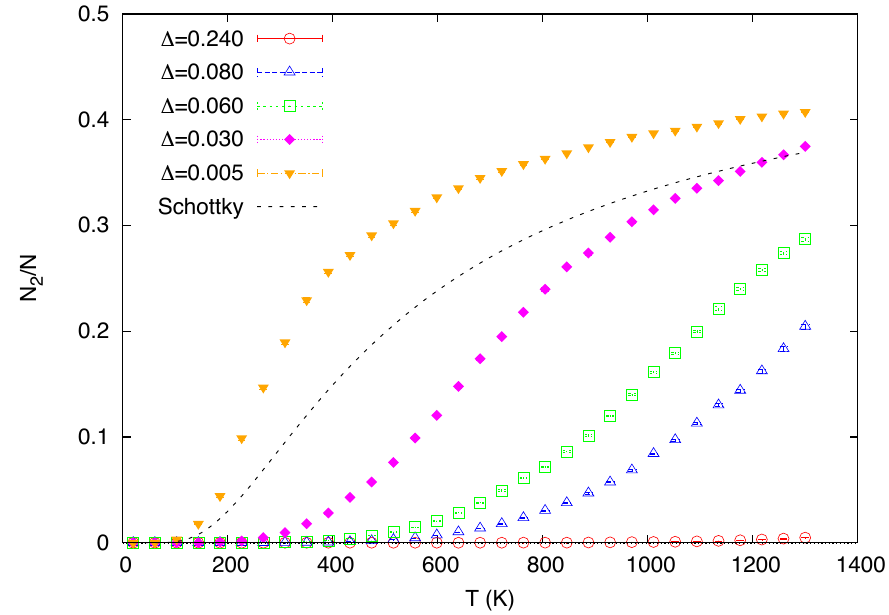
Figure 2. Calculated temperature dependence of the relative occupation of state 2 for a varying value of the mixing energy ∆ (in eV). A similar curve obtained from the simple two-level statistics (with ∆ E/k (labeled as